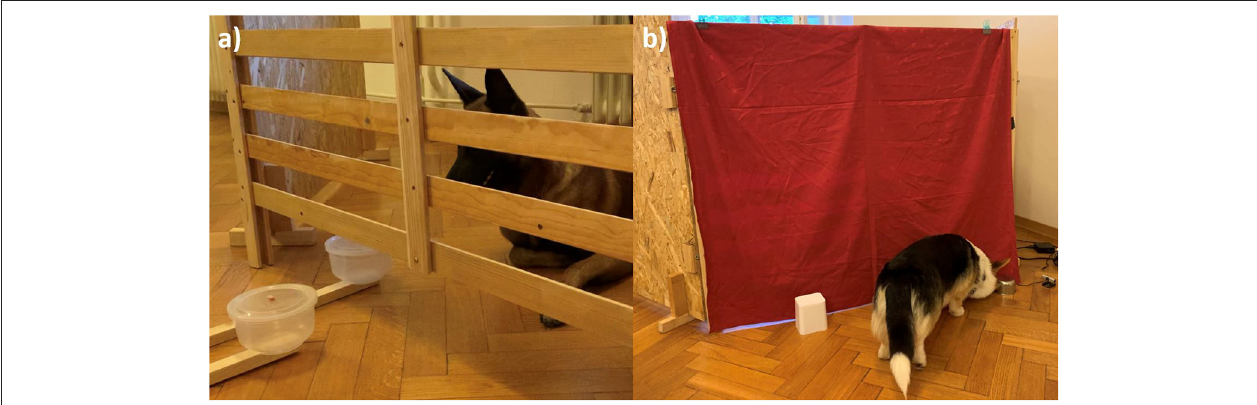
FIGURE 1 | (a) Setup and bowls position for the delay of gratification test. The dog refrains from selecting the accessible LQR and waits for the HQR, which enters the enclosure after a certain delay. (b) Design and location of the bowls for the reversal learning test. The dog selected the metal bowl by approaching and touching it. Immediately thereafter, the experimenter, hidden behind the curtain, lifted the bowl to show whether it contained the